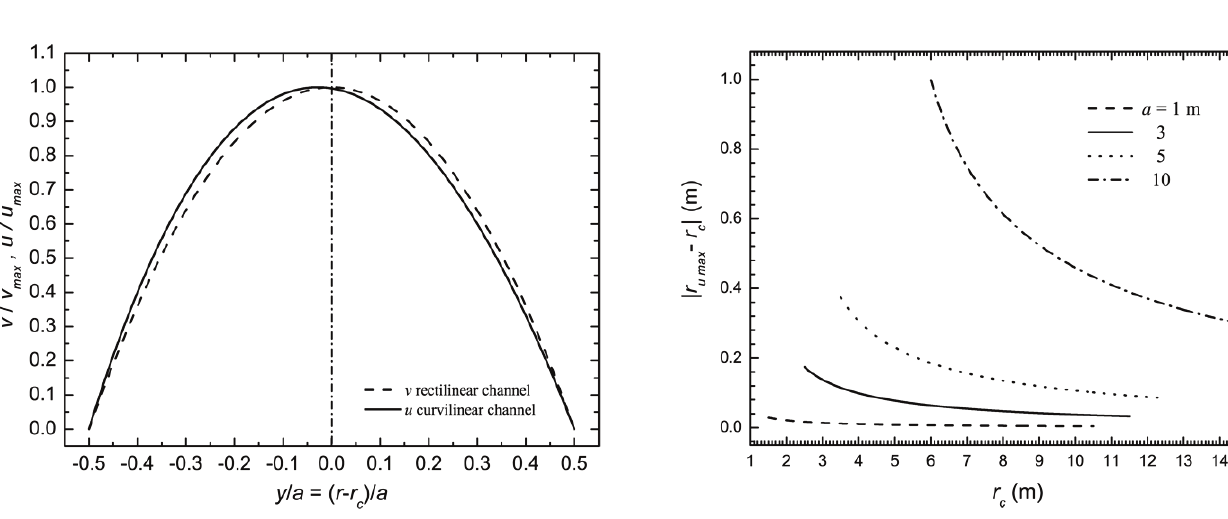
Figure 13. Distance between the point where the velocity is maximum , as a function of the radius of curvature and the center of the channel r c of the channel. Each curve is calculated for a different value of channel width a